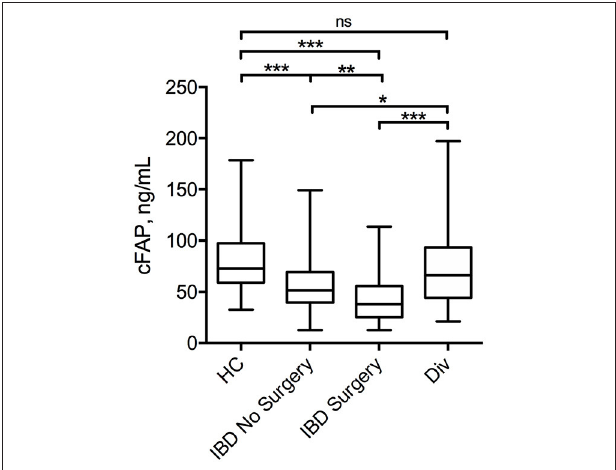
FIGURE 1 | Box plot displaying the concentration of cFAP in patients with IBD attending routine outpatient consultation ( n = 152) or undergoing surgery ( n = 120) as compared with healthy controls (HC, n = 160) and patients with diverticulitis (Div, n = 20). Statistical analysis was performed by Student t -test, * p = 0.04; ** p < 0.001; *** p <